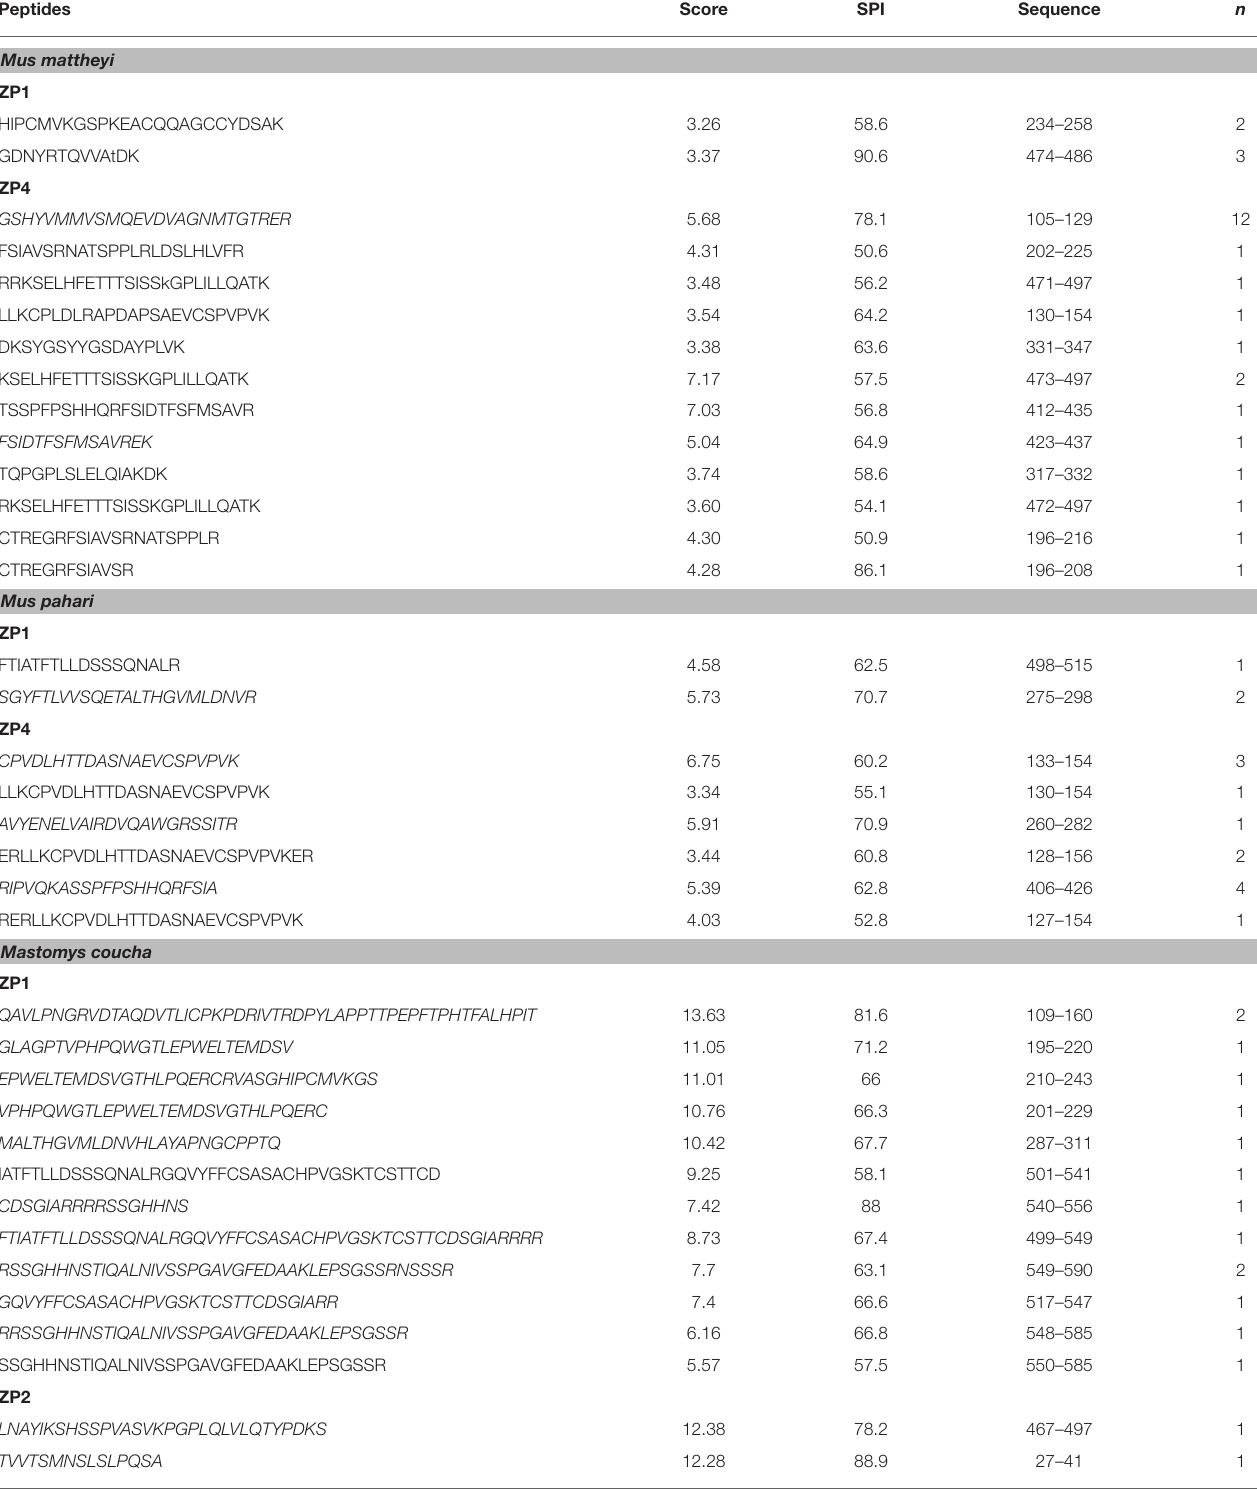
TABLE 2 | Peptides identified by proteomic analysis in Mus mattheyi , Mus pahari, and Mastomys coucha ZPs. Peptides Score SPI Sequence